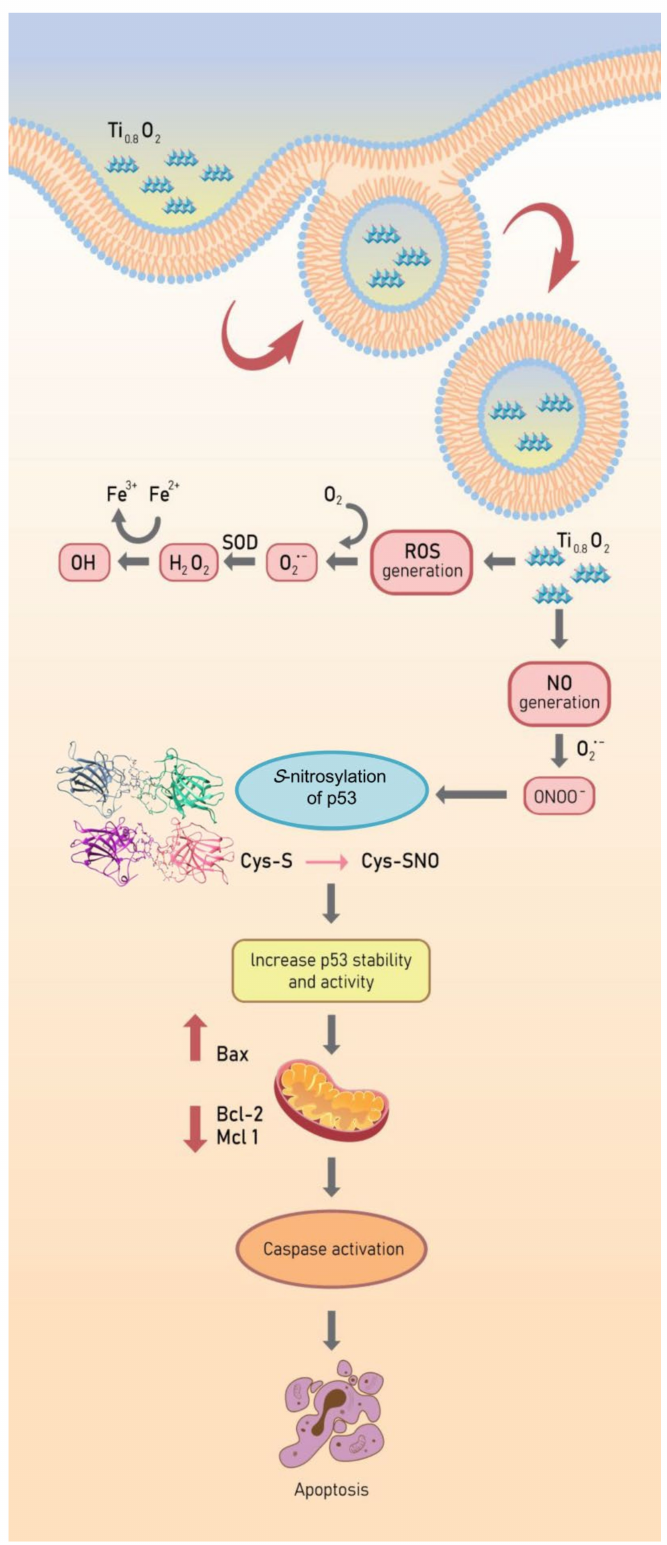
Figure 10. Schematic diagram of Ti 0.8 O 2 nanosheet-mediated peroxynitrite generation that was associated with apoptosis via p53 upregulation in non-small cell lung